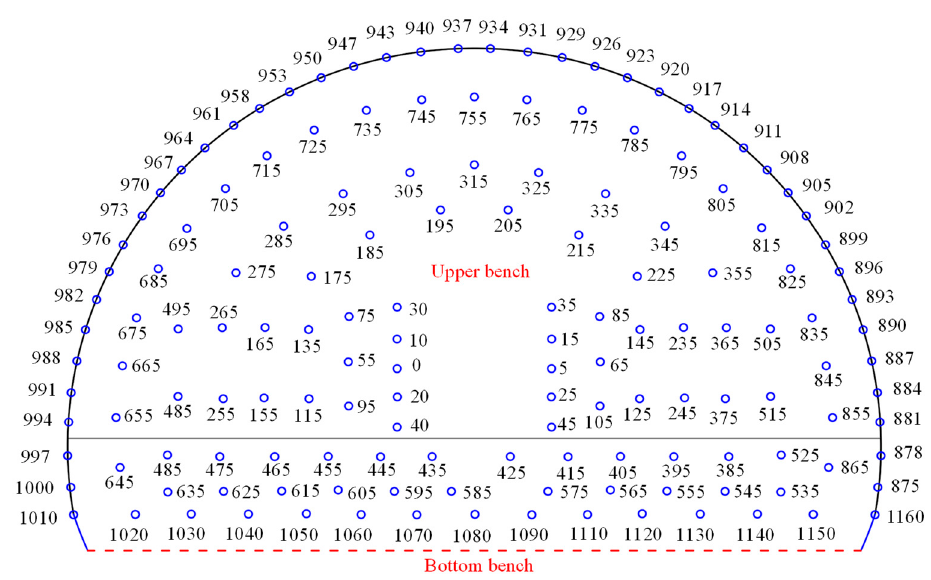
Figure 4. The blasting hole arrangement and initiation sequence of tunnel electronic detonators.